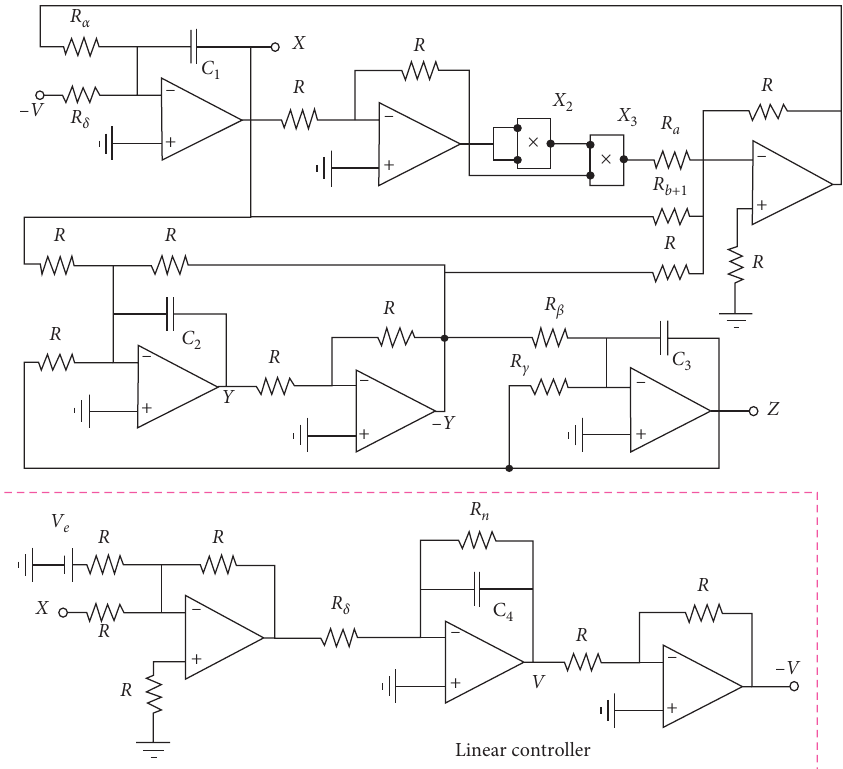
Figure 10: Schematic of Chua’s oscillator coupled with the linear dynamical